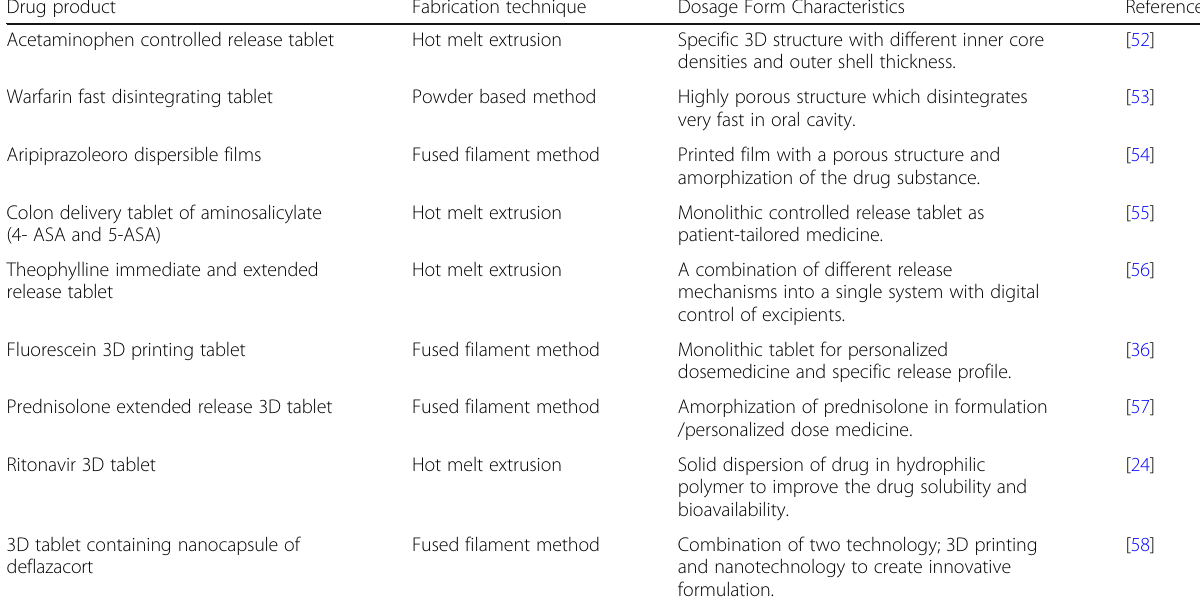
Table 2 Proprietary 3D printing drug products Drug